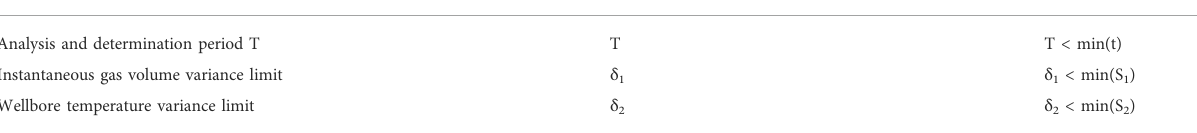
TABLE 3 Rules for setting the initial value of model parameters.